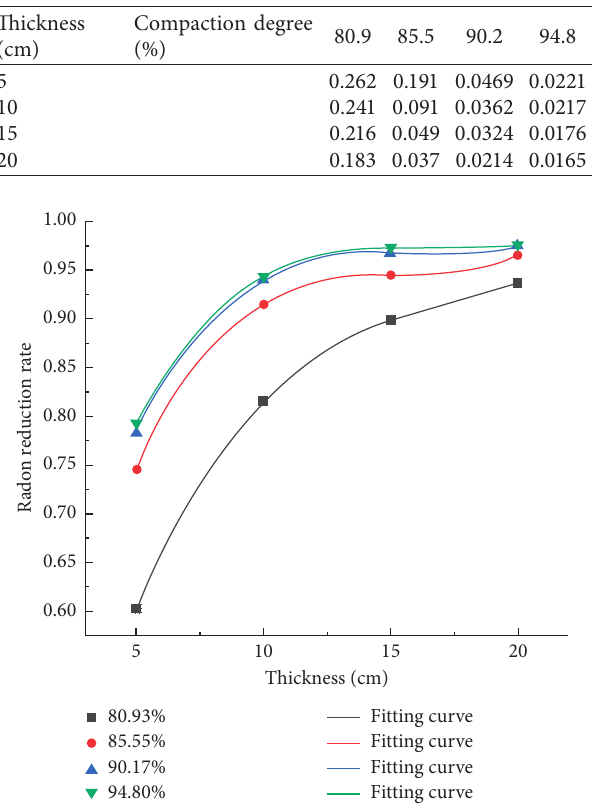
Figure 4: Relation curve between radon reduction rate and thickness.